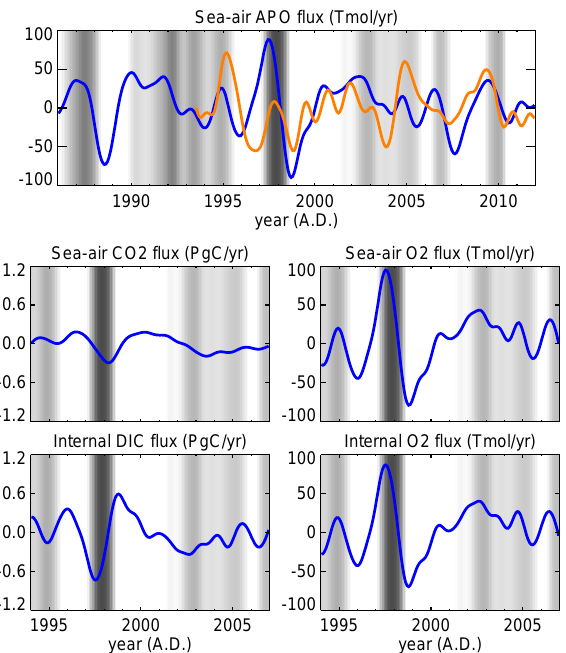
Fig. 7. Top: Interannual anomalies of the sea–air flux of atmo- Figure 7. Top: interannual anomalies of the sea–air flux of atmo- spheric potential oxygen (APO) in the tropical Pacific, inferred from spheric potential oxygen (APO) in the tropical Pacific, inferred from SOCAT (run SFC , blue) or independently estimated from atmo- SOCAT (run SFC , blue) or independently estimated from atmo- spheric O 2 / N 2 ratios and CO 2 mixing ratios (atmospheric APO spheric O 2 /N 2 ratios and CO 2 mixing ratios (atmospheric APO in- inversion, R¨odenbeck et al., 2008, 5 sites, updated, orange). Tem- version, Rödenbeck et al. (2008); five sites, updated; orange). Tem- poral filter and sign convention as in Fig. 3. The background shad- poral filter and sign conventions as in Fig. 3. The background shad- ing indicates El Ni˜no (MEI index). Middle: Over selected years ing indicates El Niño (MEI). Middle: sea–air fluxes of CO 2 and O 2 for illustration, sea–air fluxes of CO 2 and O 2 composing the APO composing the APO flux (Eq. 5) for selected years for illustration. flux (Eq. (5)). Bottom: Ocean-internal sources and sinks of DIC Bottom: ocean-internal sources and sinks of DIC and O 2 . Vertical and O 2 . Vertical axes of all panels span the same range on a molar axes of all panels span the same range on a molar basis.